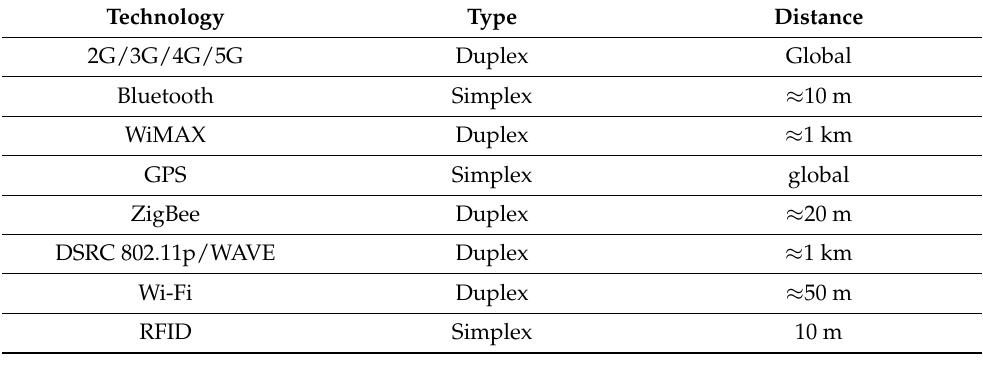
Table 1. Communication technologies in VANET [2].